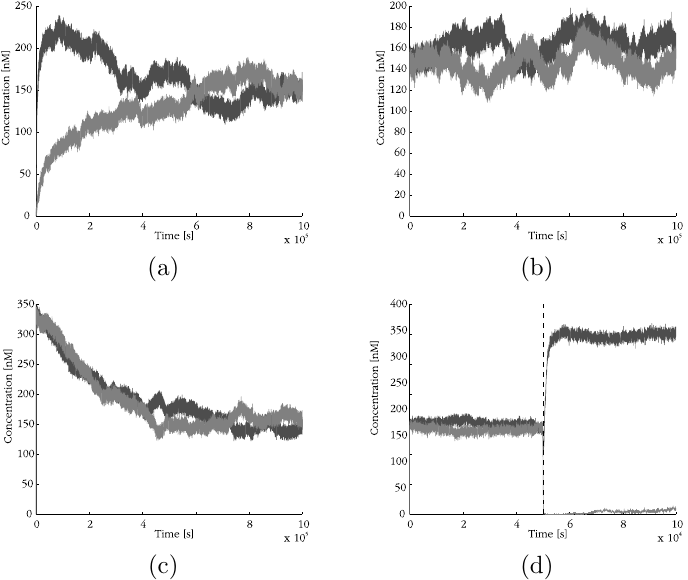
Figure 7. Time evolution of protein dimer concentrations from different initial states of the system. Figures (a), (b) and (c) present a scenario where state that does not have a valid logical interpretation is achieved from some arbitrary initial state. Figure (d) presents initialization of the system state with the introduction of external input, i.e. i or j . Concentrations of protein dimer X 2 are presented with dark-grey line and concentrations of protein dimer Y 2 with light-grey line.